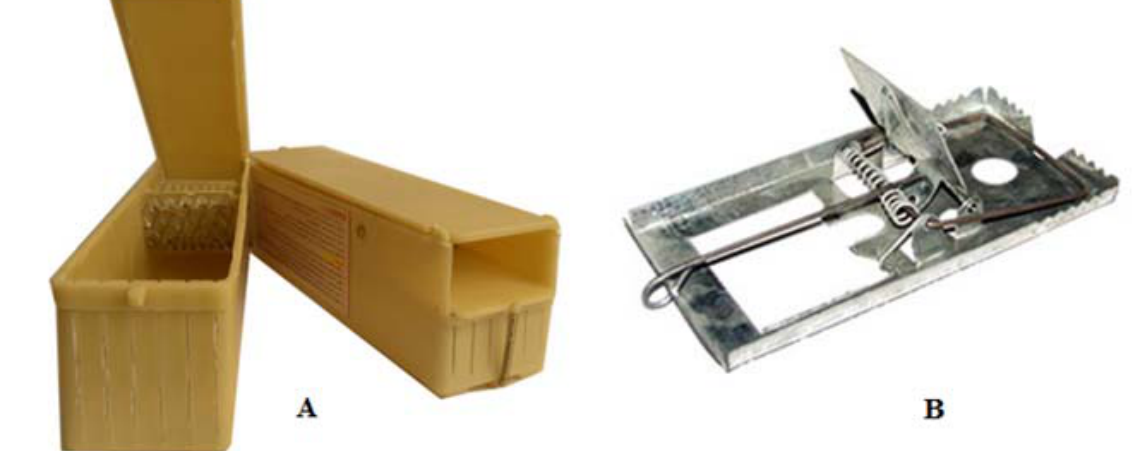
F IGURE 1. A: Faragir traps, B: snap